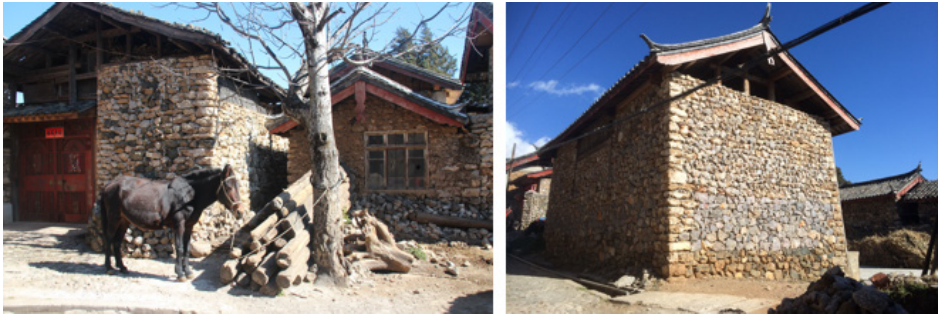
Figure 24. Buildings mainly constructed with stones in a village of the Naxi (photos by the first